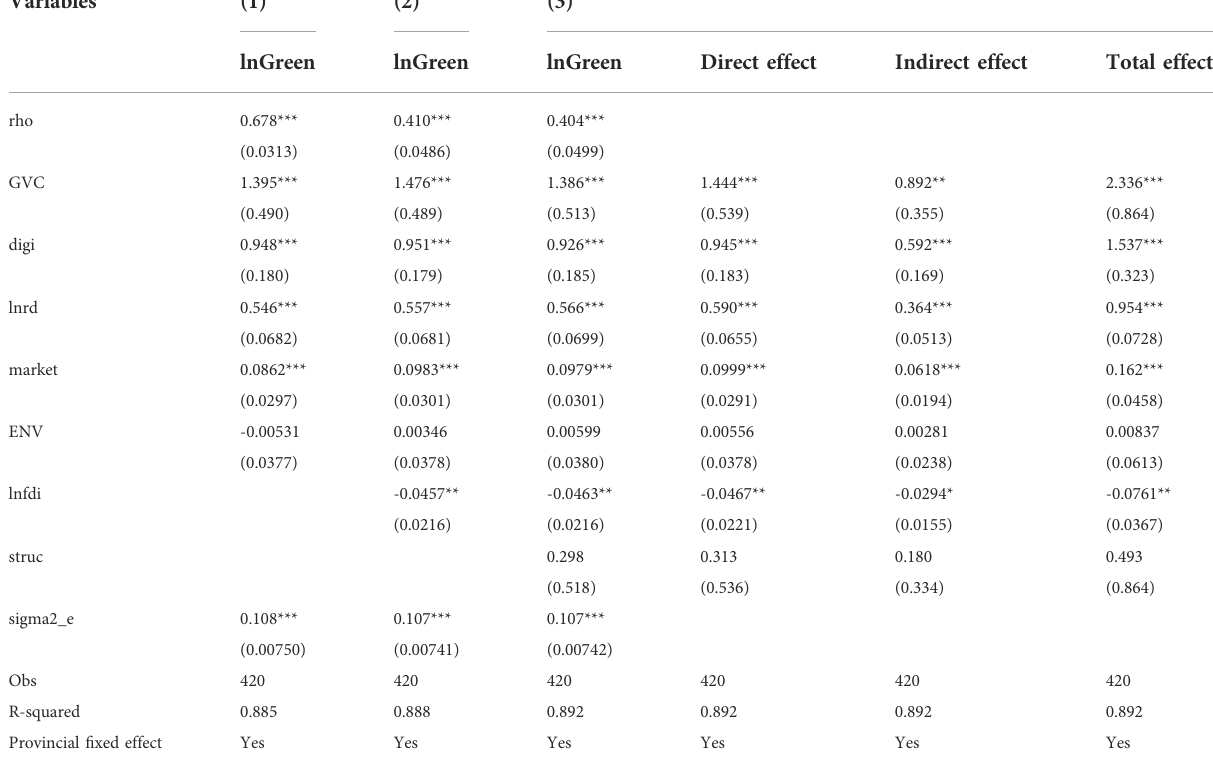
TABLE 6 Test results of spatial autoregressive model